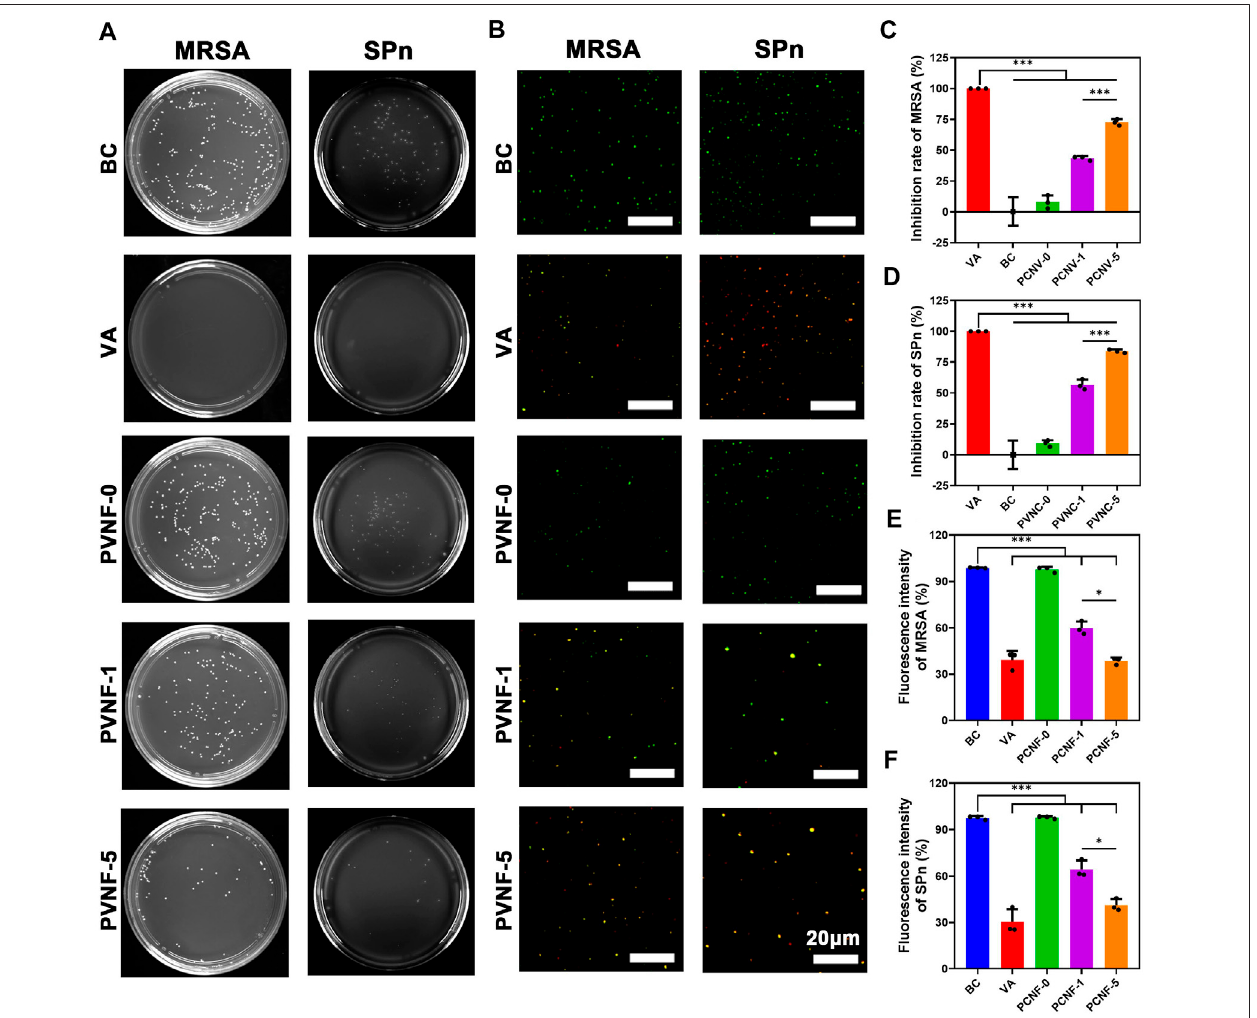
FIGURE 5 | (A) Representative images of survival methicillin-resistant Staphylococcus aureus (MRSA) and Streptococcus pneumoniae (SPn) on LB/blood agar dishes after being treated with PVNF-n ( n (cid:1) 0, 1, and 5, respectively). (B) Fluorescence microscopy images of DMAO and EthD-III – stained MRSA and SPn incubated in thepresenceofthemedium(blankcontrol,BC),VA(positivecontrol,VA),andPVNF-n( n (cid:1) 0,1,and5,respectively)conditionedmedium.Livebacteriaarestainedgreen and dead bacteria are stained red. (C, D) Inhibition rate of PVNF-n for MRSA and SPn, respectively ( N (cid:1) 3). (E, F) Fluorescence intensity of PVNF-n for MRSA and SPn, respectively ( N (cid:1) 3). Scale bar: 20 μ m * p < 0.05, and *** p <